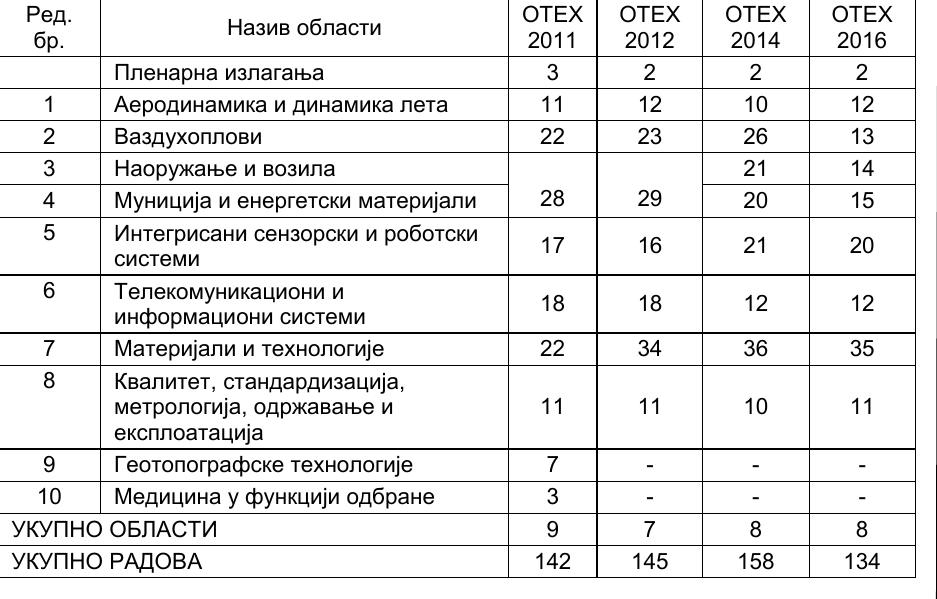
Table 1 – Overview of the number of all papers grouped by the Conference areas Ред